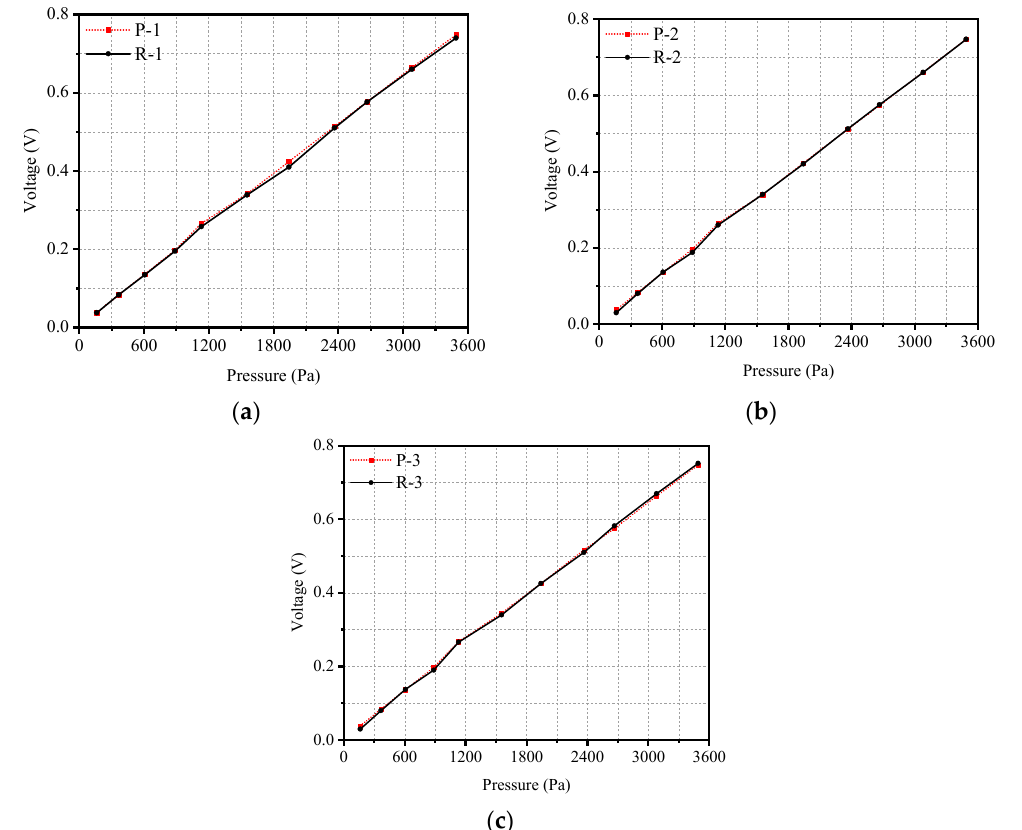
Figure 5. Calibration results for three cycles (“P” represents positive stroke; “R” represents reverse stroke, the same below): ( a ) pressure cycle 1, ( b ) pressure cycle 2, ( c ) pressure cycle 3.